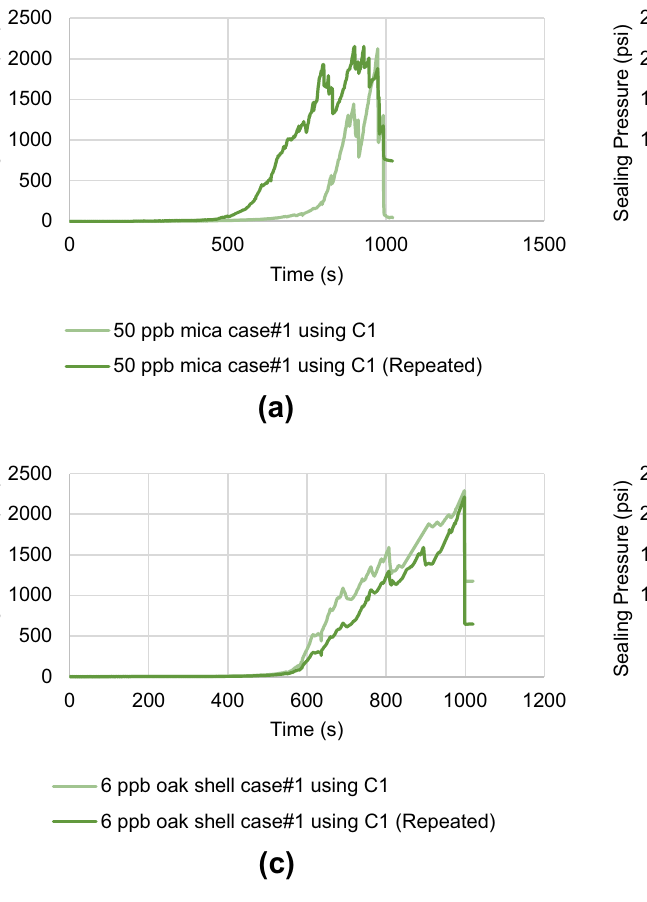
Fig. 30 Repeated tests for Mica and Oak Shell using C1 and